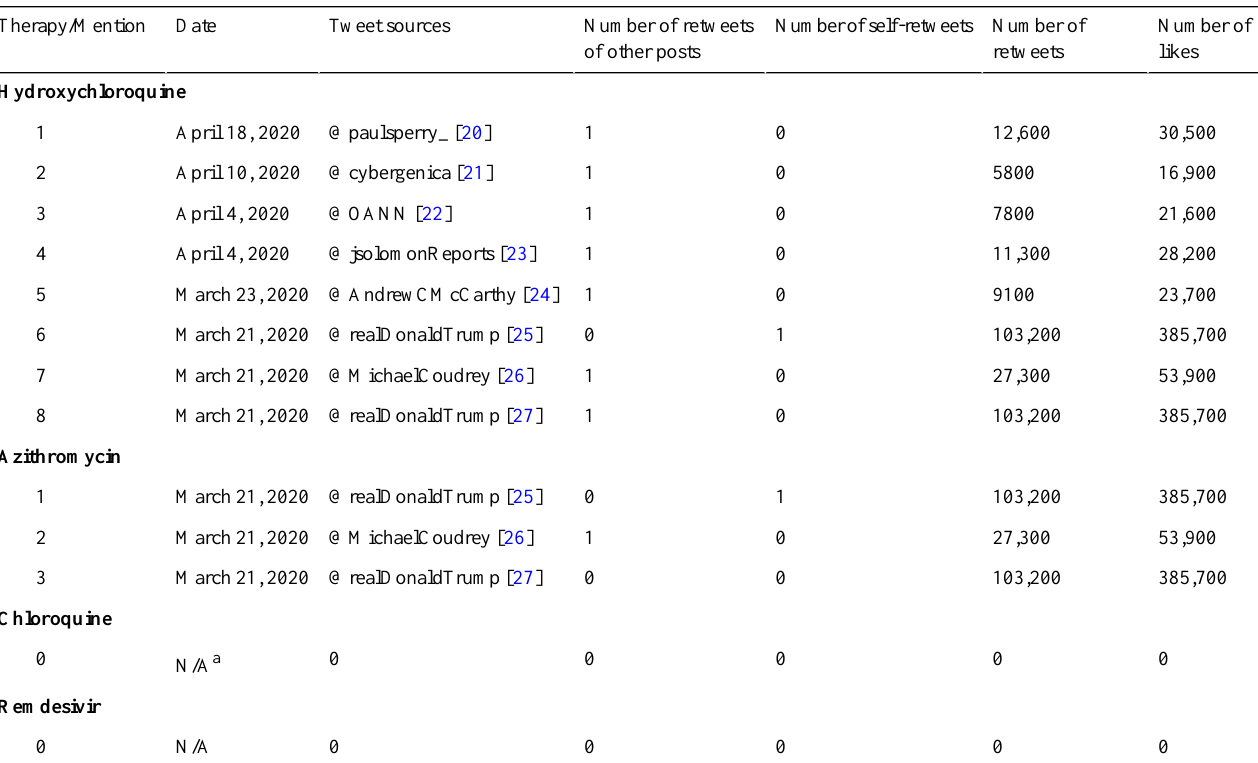
Table 1. Characteristics Donald J Trump’s tweets that mention hydroxychloroquine, chloroquine, chloroquine, and remdesivir, including key metrics such as retweets, likes, and whether the tweets were retweets or self-composed tweets by Donald J